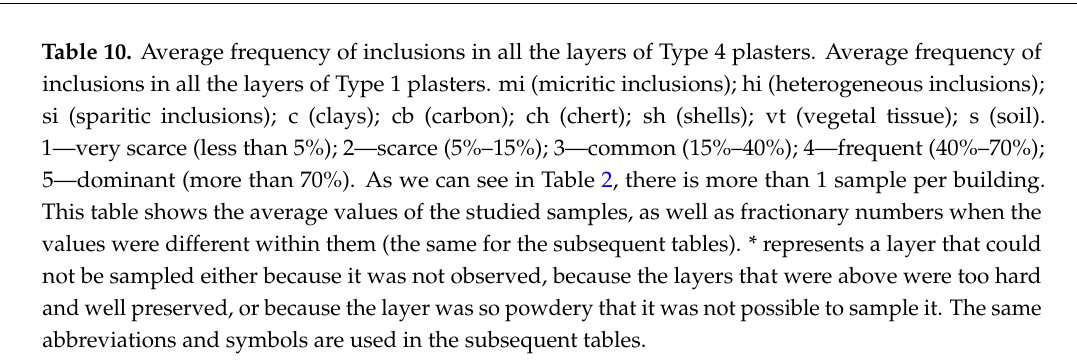
Table 9. Proportions in the Type 4 plasters; the data are based on the percentage of matrix (ma), inclusions (in) and pores (po) in each layer. * represents a layer that could not be sampled either because it was not observed, because the layers that were above were too hard and well preserved or because the layer was so powdery that it was not possible to sample it.